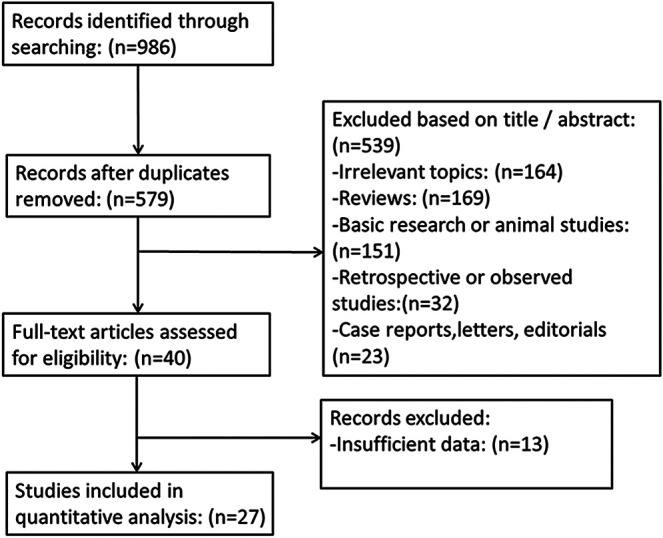
Flow diagram of the study selection process.